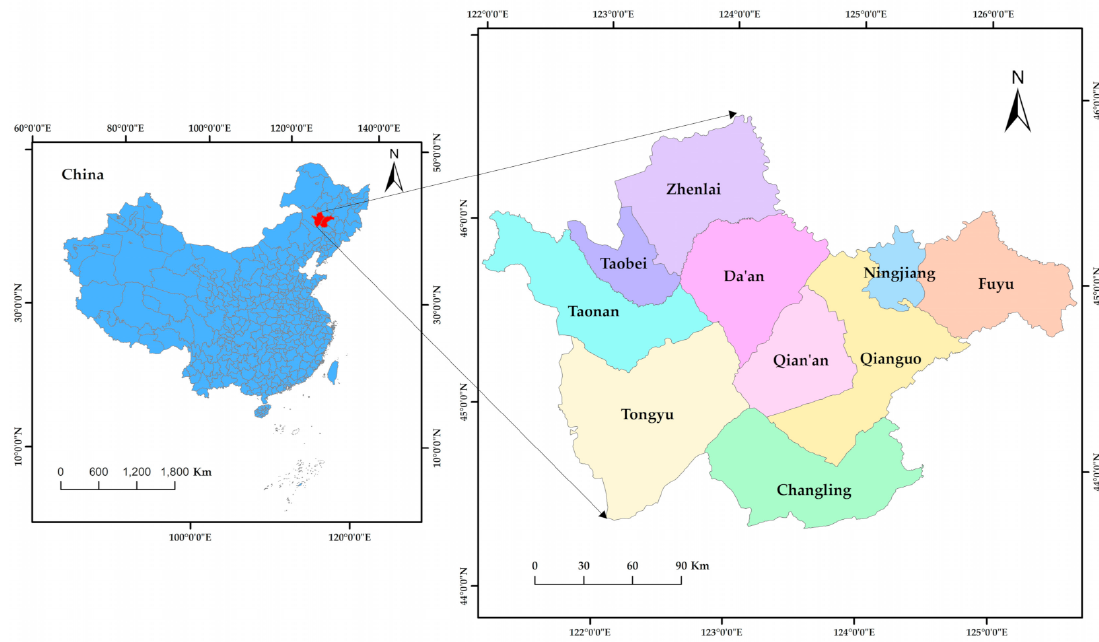
Figure 1. Map of Western Jilin